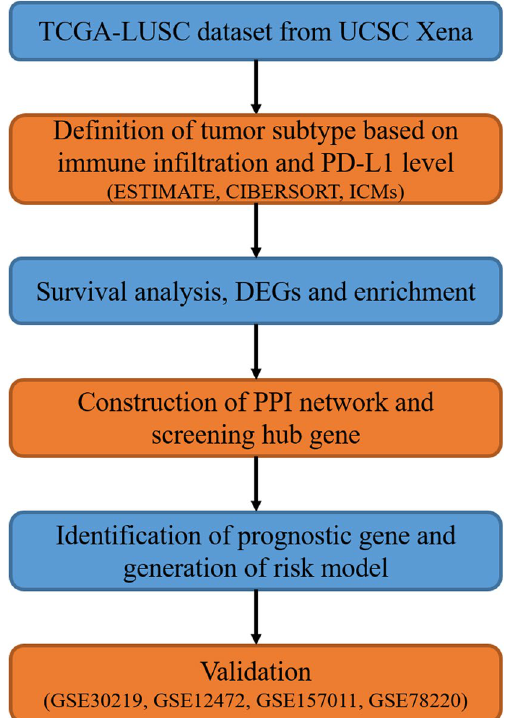
Figure 1. Flow chart of this study. The flow chart shows the strategy for developing and validating an immune- related 13-gene signature. This signature is constructed to predict immunotherapy responses and the overall survival of lung squamous cell